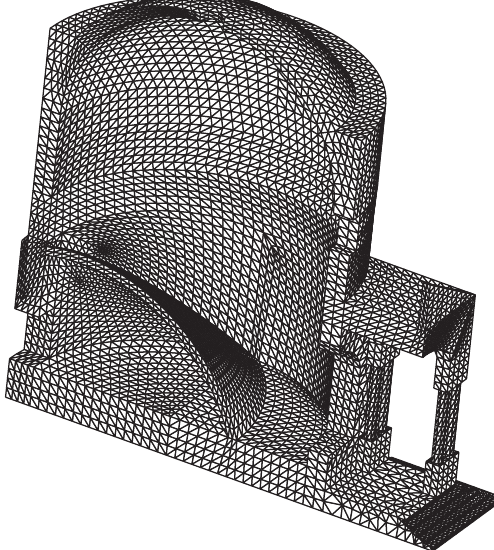
Figure 11: Finite element mesh of Chapel XVII: half of the